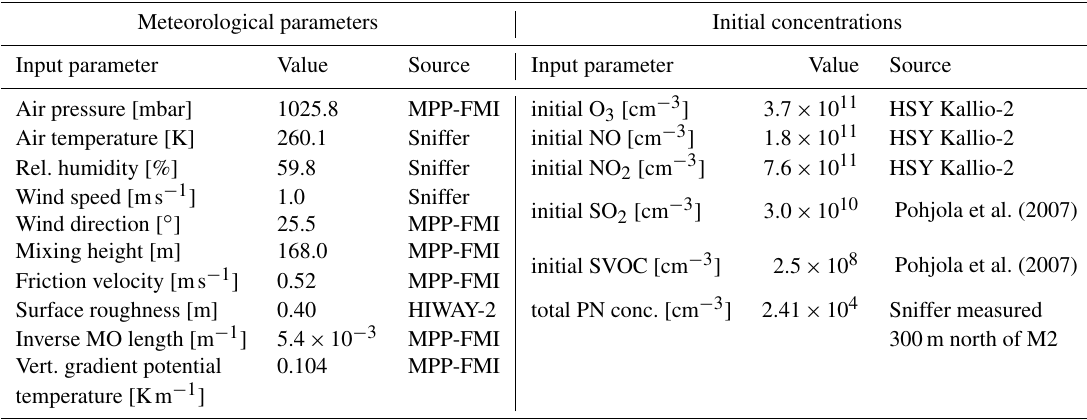
Figure 9. Coupling of the dispersion models and aerosol dynamics models. Table 4. Overview of meteorological input and initial conditions for the Urban